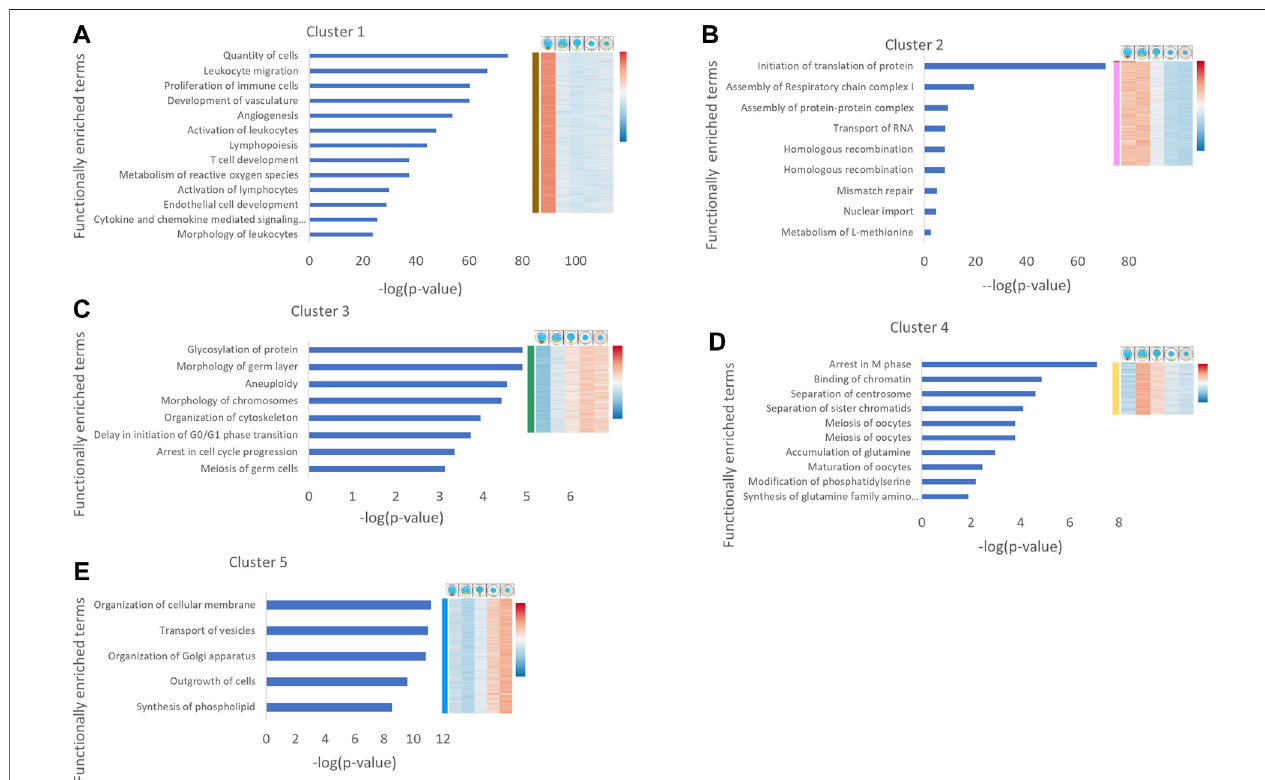
FIGURE 2 | Functional enrichment analysis of gene expression clusters in oogenesis. Human homologues of genes from each cluster were analyzed by IPA. Cancer related functions were removed. The main functionally enriched terms for each cluster are shown. The X axis is the [ – log ( p -value)] corrected for FDR. Heat map ontherightshowsthecorrespondingclusterexpressionpatternderivedfrom Figure1C .Cartoonsabovetheheatmapdepictthedifferentstages.Theheatmapshows relative expression of genes, where red denotes higher expressed genes and blue denotes lower expressed genes.